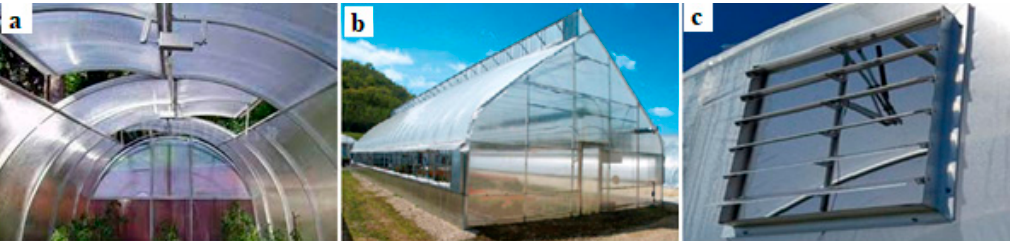
Figure 2. Different types of greenhouse openings: ( a ) roof vents; ( b ) ridge vents; ( c ) side vents.